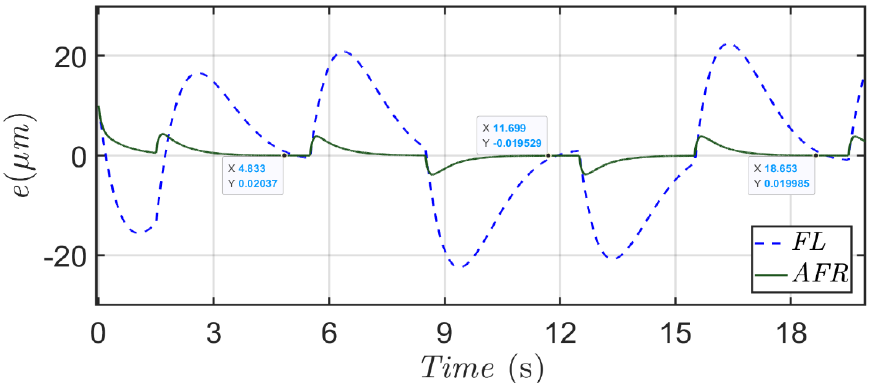
Figure 5. Histories of positioning errors for the proposed method (green line) and feedback linearization method (blue dash line) with respect to a desired trapezoid trajectory.